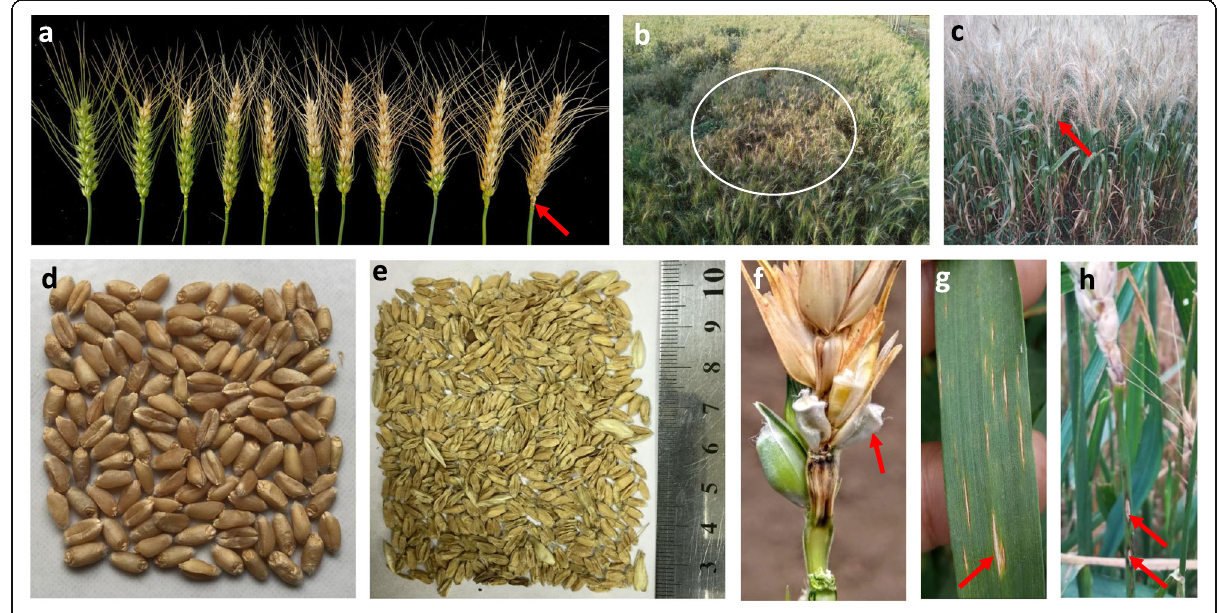
Fig. 1 Symptoms of blast disease in different parts of wheat plants. a Complete to partial infections (right to left) in wheat spikes collected from a blast-affected field. Arrow indicates the point of infection. b A characteristic patch (see the circle) of blast infection indicating the early stage of field infection. c Complete bleaching (arrow) of 100% spikes in a blast-devastated field. d Unaffected and normal color of wheat grains. e Severely shrivelled or wrinkled and discoloured wheat grains affected by the wheat blast. f Two shrivelled grains (whitish color, arrow) and a normal (green)-colored unaffected grain just below the infection point in a spike. g Typical eye-shaped lesion (arrow) with gray center. h Brown colored lesions with gray centers (arrows) of an infected stem of